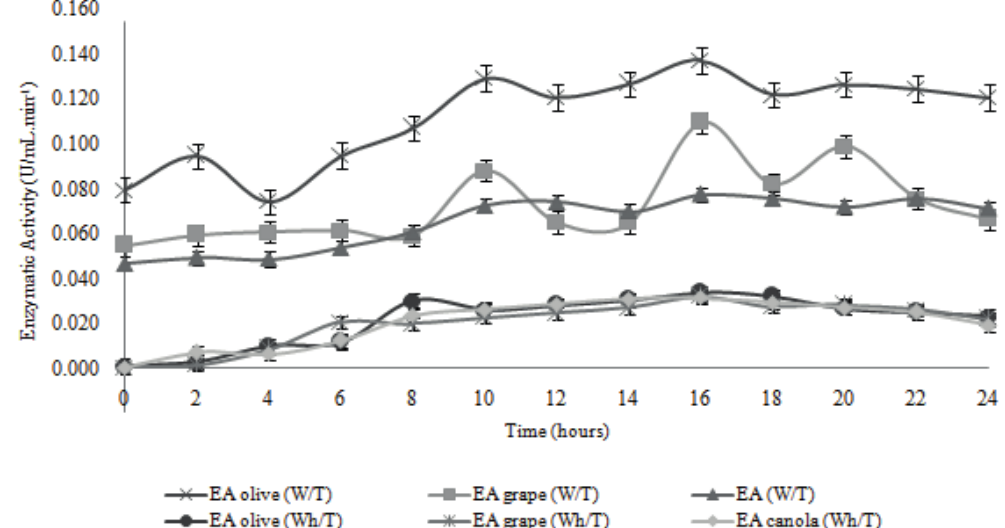
Figure 2 - Enzymatic activities produced by isolate G40 using olive oil, grape seed oil, and canola oil as the main carbon source, with and without the addition of Tween 80. Experiment performed in the orbital shaker at 30 ºC , 120 rpm for 24